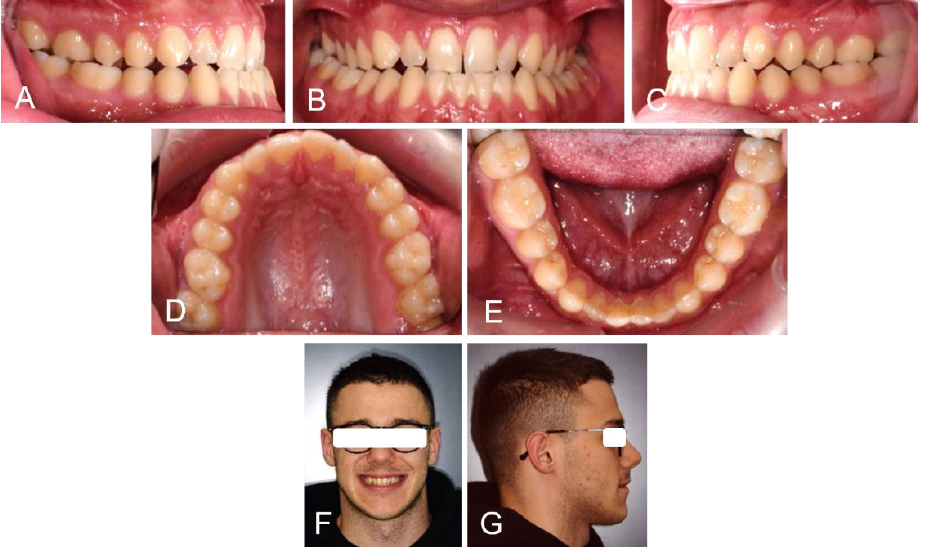
Figure 1. Extra and intraoral photos of the patient before treatment: Right lateral occlusion ( A ); Frontal occlusion ( B ); Left lateral occlusion ( C ); Upper occlusion ( D ); Lower occlusion ( E ); Patient smile ( F ) and right profile ( G ).